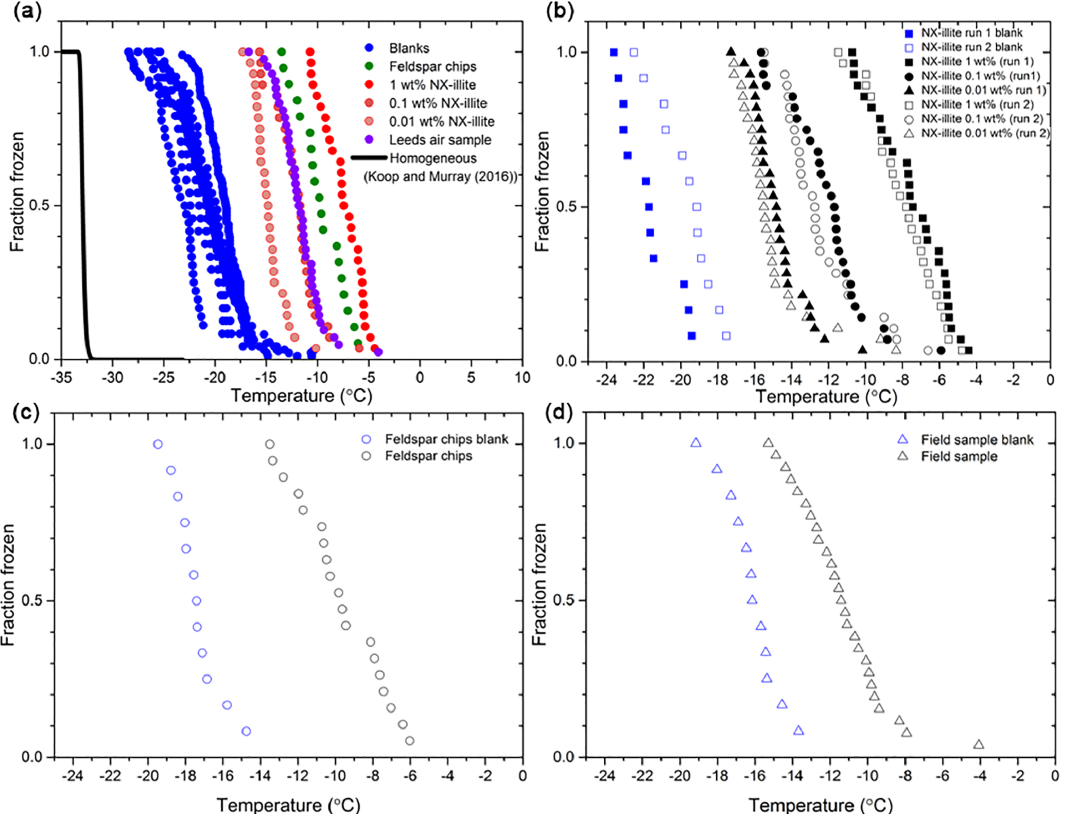
Figure 5. The fraction of droplets frozen as a function of temperature on cooling for a range of samples. (a) The fraction frozen curves for the IR-NIPI experiment showing standard blank runs and the sample runs from this study. The homogeneous freezing of water as predicted with the Koop and Murray (2016) parameterisation is also shown in black. (b) Fraction frozen plot for the internal blanks vs. the corresponding NX-illite runs. (c) Fraction frozen plot for the internal blank vs. the corresponding feldspar chip run. (d) Fraction frozen plot for the internal blank vs. the corresponding field sample